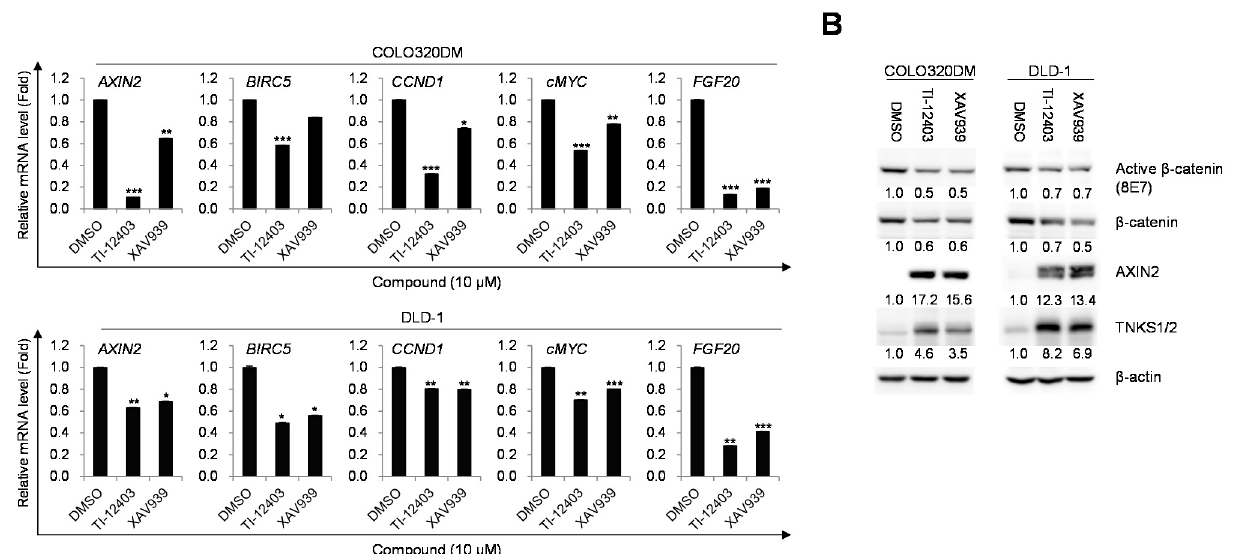
Figure 1. TI-12403 stabilizes AXIN2 and downregulates β -catenin signaling in COLO320DM and DLD-1 cells. Human colorectal cancer (CRC) COLO320DM and DLD-1 cells were treated with 10 μ M of each TI compound for 24 h. ( A ) mRNA expression levels of the indicated β -catenin target genes ( AXIN2 , BIRC5 , CCND1 , cMYC , and FGF20 ) were quantified using quantitative polymerase chain reaction (qPCR). XAV939 was used as a reference control. Data represent the mean ± stand- ard deviation (SD) of three independent experiments. * p < 0.05, ** p < 0.01, *** p < 0.001 versus respective DMSO-treated cells. ( B ) Whole cell lysates were subjected to immunoblotting for detection of active β -catenin (ABC), total β -catenin, TNKS1/2, and AXIN2. β -actin was used as a loading control. The density of each band was measured by Image J software and normalized to that of β -actin. Data represent the mean ± SD of three independent experiments. * p < 0.05, ** p < 0.01 versus respective DMSO-treated cells. ( C ) COLO320DM and DLD-1 cells were treated with 10 μ M TI-12403 and im- munostained for AXIN2 (green) and β -catenin (red). Nuclear DNA was counterstained with DAPI (blue). Scale bar, 20 μ m. ( D ) Quantification of the mean fluorescence intensity in Figure 1C. * p < 0.05, ** p < 0.01, *** p < 0.001 versus corre- sponding cells. ( E ) COLO320DM and DLD-1 cells were transfected with either TOP- (wild-type TCF binding sites) or FOP- (mutated TCF binding sites) flash reporter plasmid and then treated with 10 μ M TI-12403 for 48 h. Transcriptional activity was measured with a luciferase reporter assay system and was calculated by dividing the TOP ratio by the FOP ratio